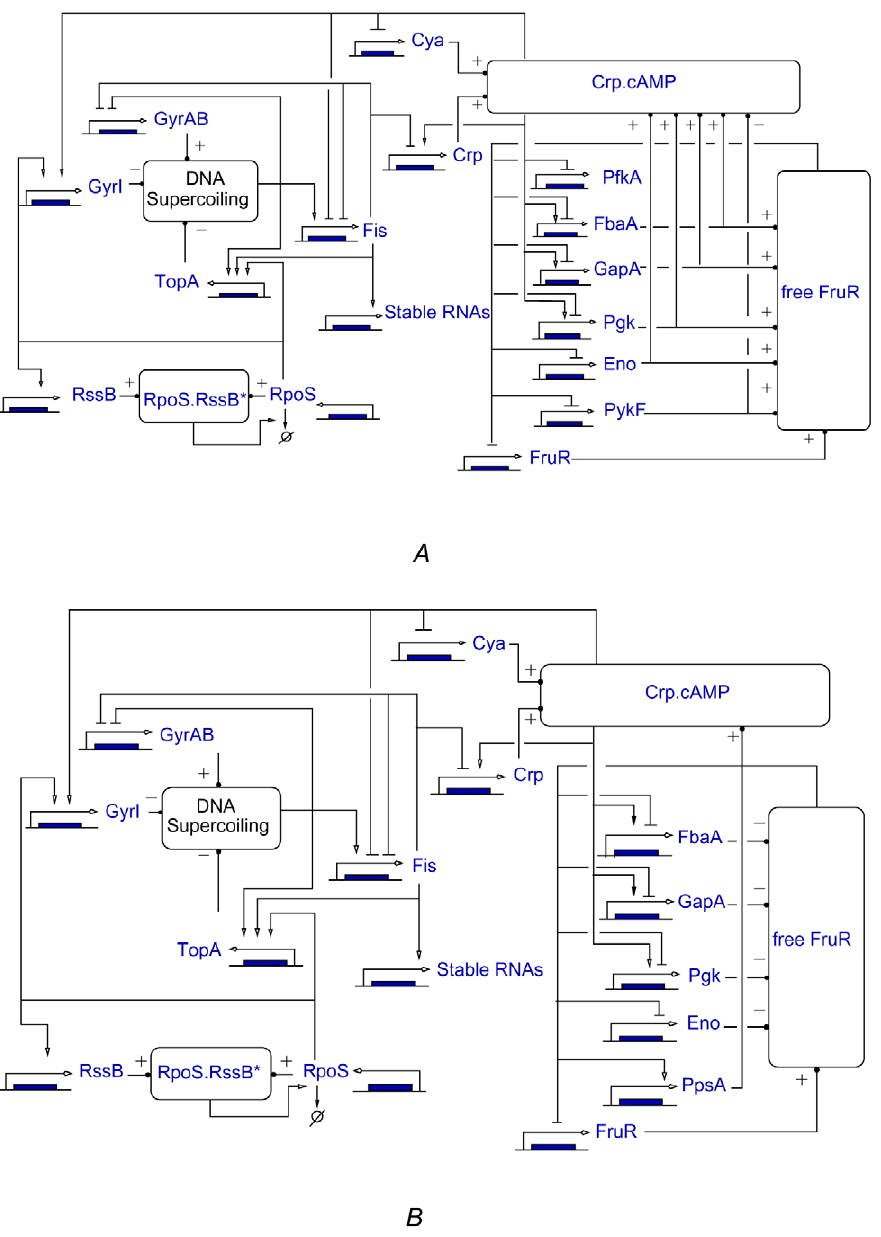
Figure 5. Networks of direct and indirect regulatory interactions in the case of ( A ) glycolysis and ( B ) gluconeogenesis. The networks and M 2 , taking into account allosteric effects (see Sec. 3 of Text S3). The boxes represent fast coupling are computed from the models M 2 glyco neo species, mediating the influence of metabolism and signal transduction on gene expression: Crp : cAMP, free FruR, RpoS : RssB*, and DNA supercoiling. The influence of the enzymes and other slow species on the concentration of the fast coupling species are represented by + / 2 signs. doi:10.1371/journal.pcbi.1000812.g005 Table 2. Structural features of the gene regulatory networks inferred from different models of the carbon assimilation network.